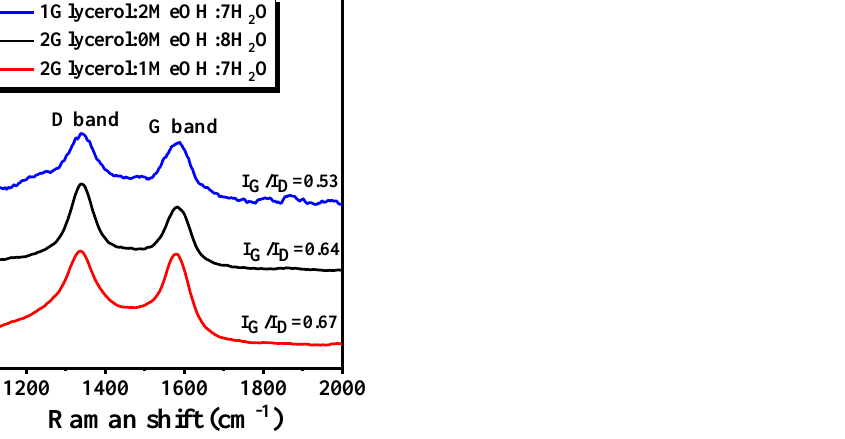
after 20 h stability test. Figure S2. XRD pattern of the Ni/Ti-500R catalysts